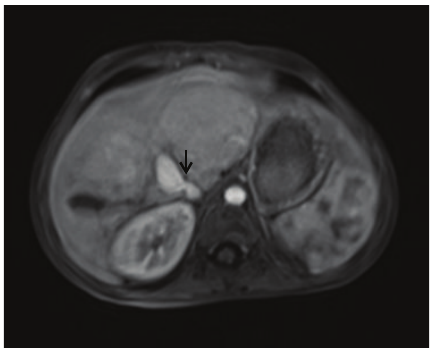
Figure 6: A 12-year-old female with complaints of vague upper abdominal discomfort. Axial image of MR angiography reveals an abnormal communication between main portal vein and inferior vena cava (arrow).